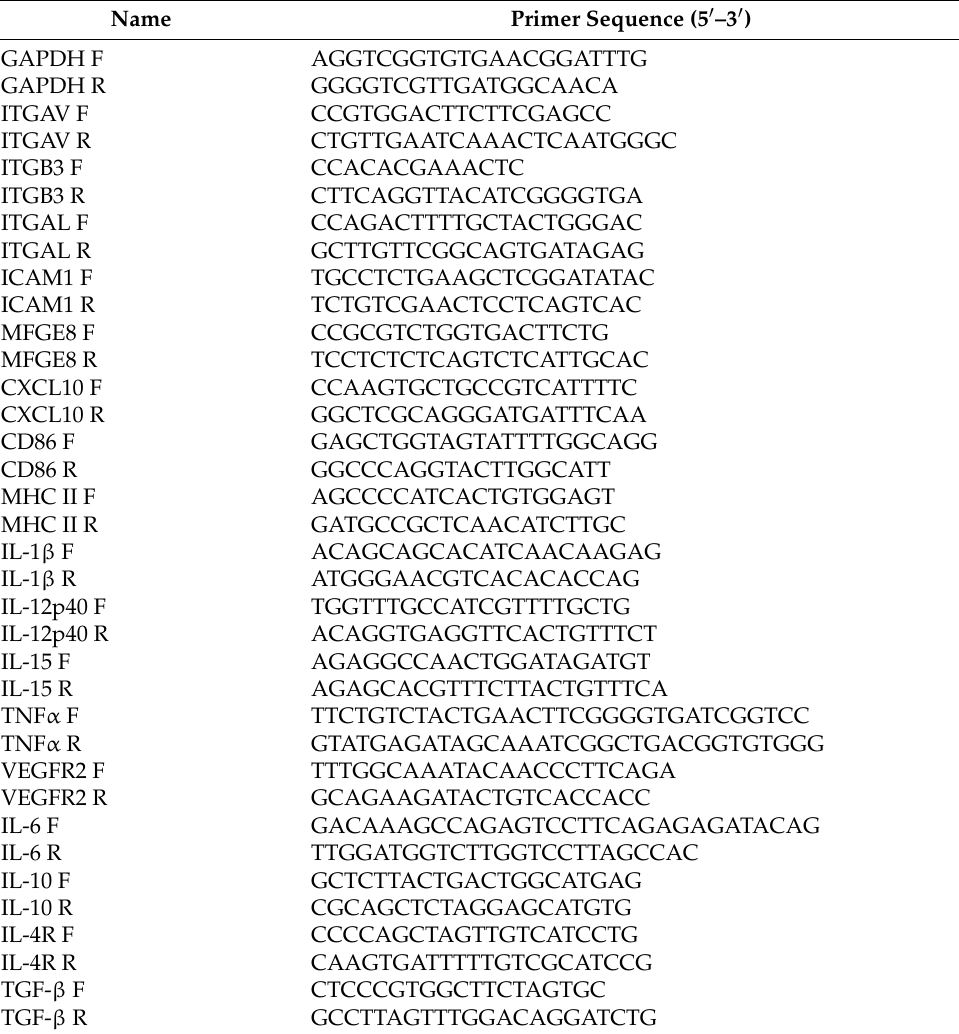
Table 1. Forward (F) and Reverse (R) primers used in Real-Time PCR.